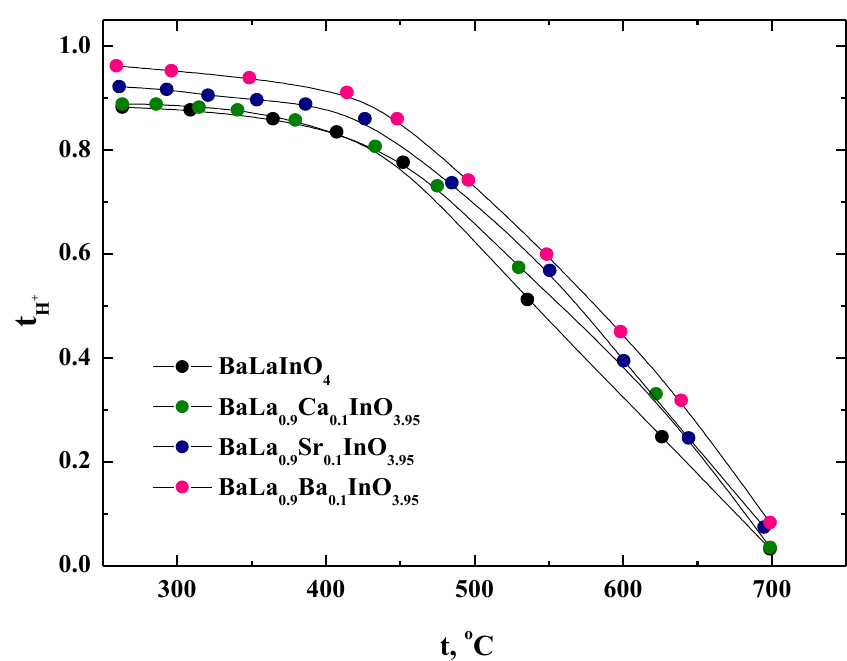
Figure 9. The temperature dependencies of the proton transport numbers of BaLaInO 4 and BaLa 0.9 M 0.1 InO 3.95 (M = Ca 2+ , Sr 2+ , and Ba 2+ ).